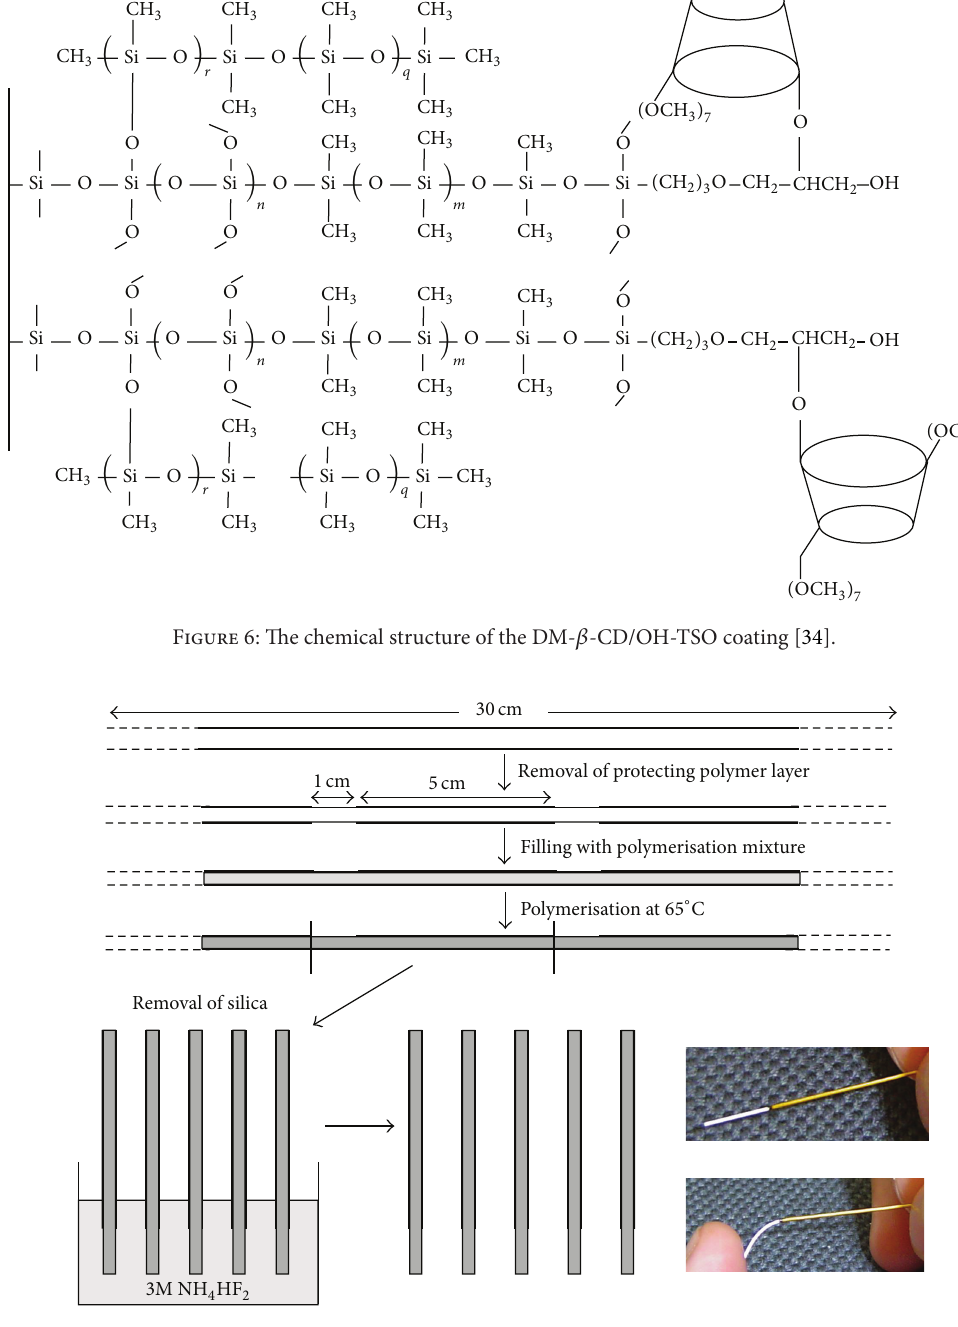
Figure 7: Preparation of molecularly imprinted fiber